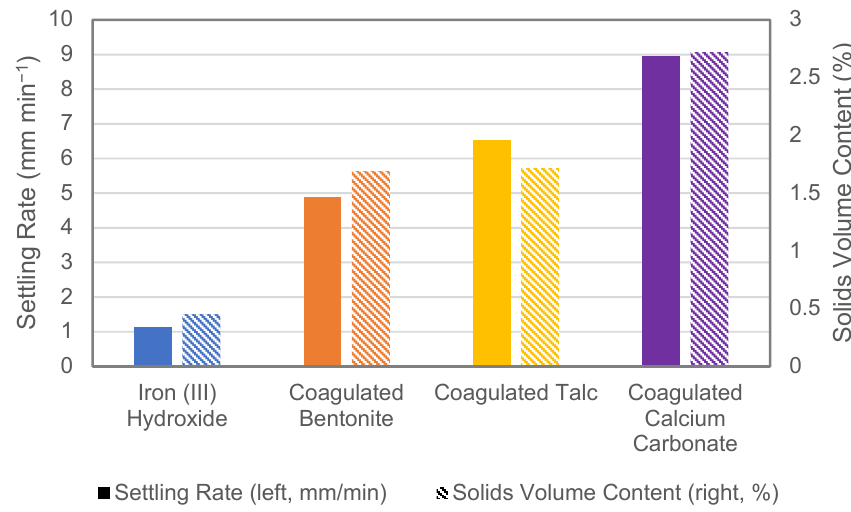
Figure 7. Primary floc settling rates (left-hand axis) and settled bed solids volume content (right-hand axis) for coagulated modified bentonite, talc and calcium carbonate, as well as pure iron hydroxide flocs.